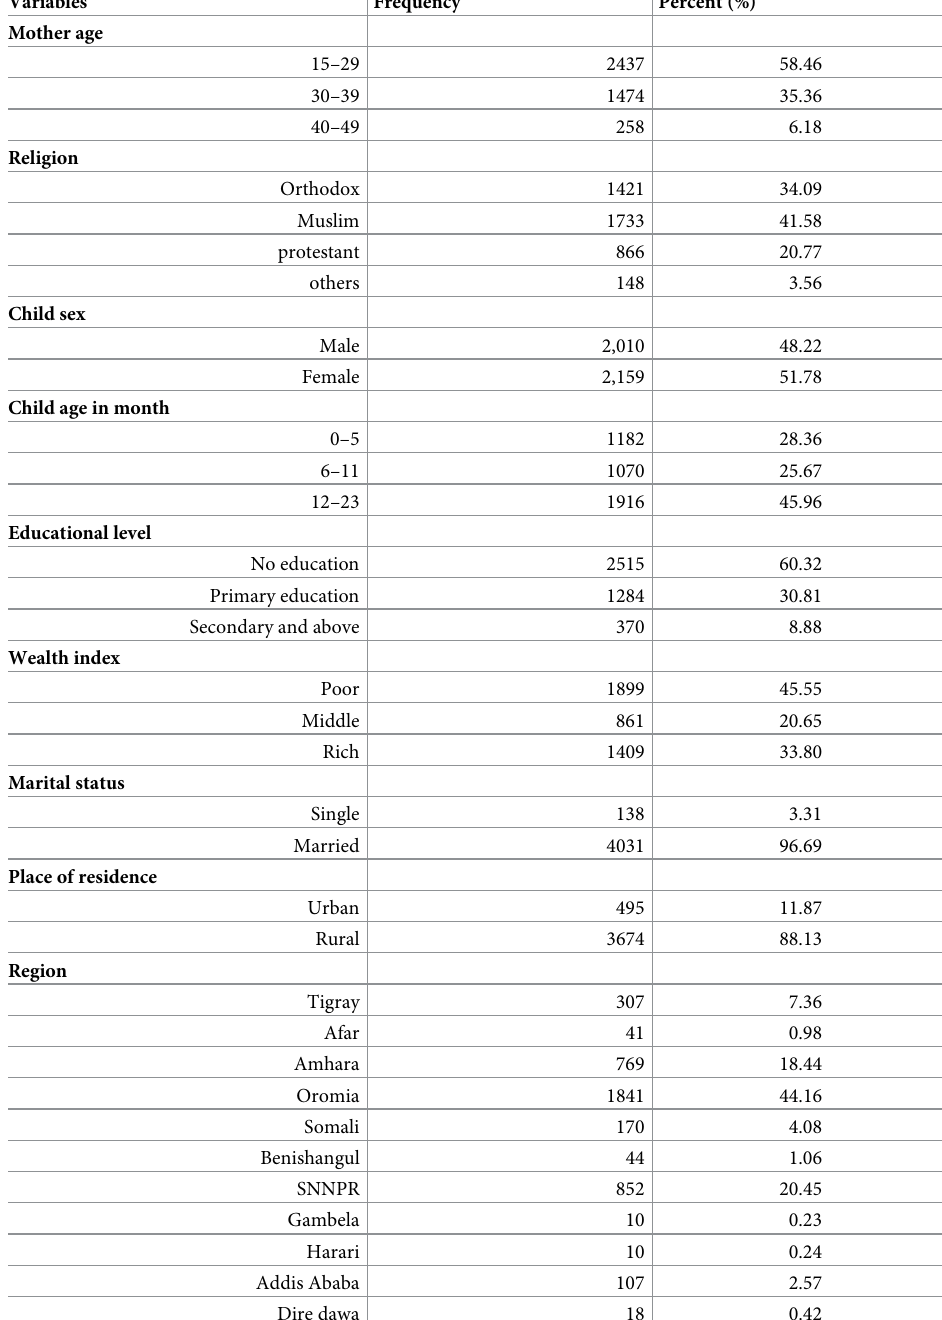
Table 1. Socio-demographic characteristics of respondents and